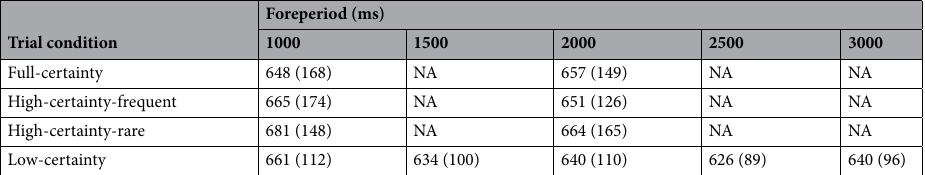
Table 3. Mean reaction times for correct trials (ms), averaged on the data of 20 participants separately for each condition and foreperiod. Standard deviations (ms) are reported in parentheses. Trial conditions with no corresponding foreperiod marked as non-applicable